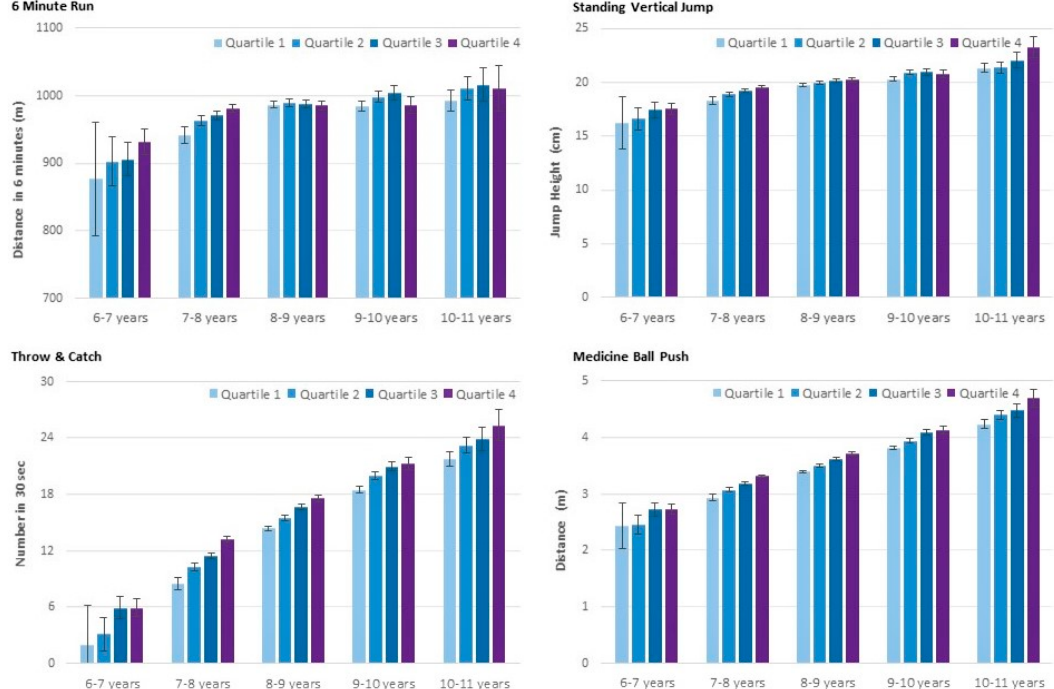
Figure 1. Endurance, muscular power and object control by age-group and age-specific quartile. Values are means, adjusted for sex, with a 95% confidence interval.